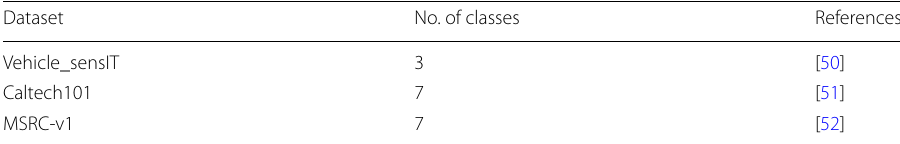
Table 3 Summary of the datasets Dataset